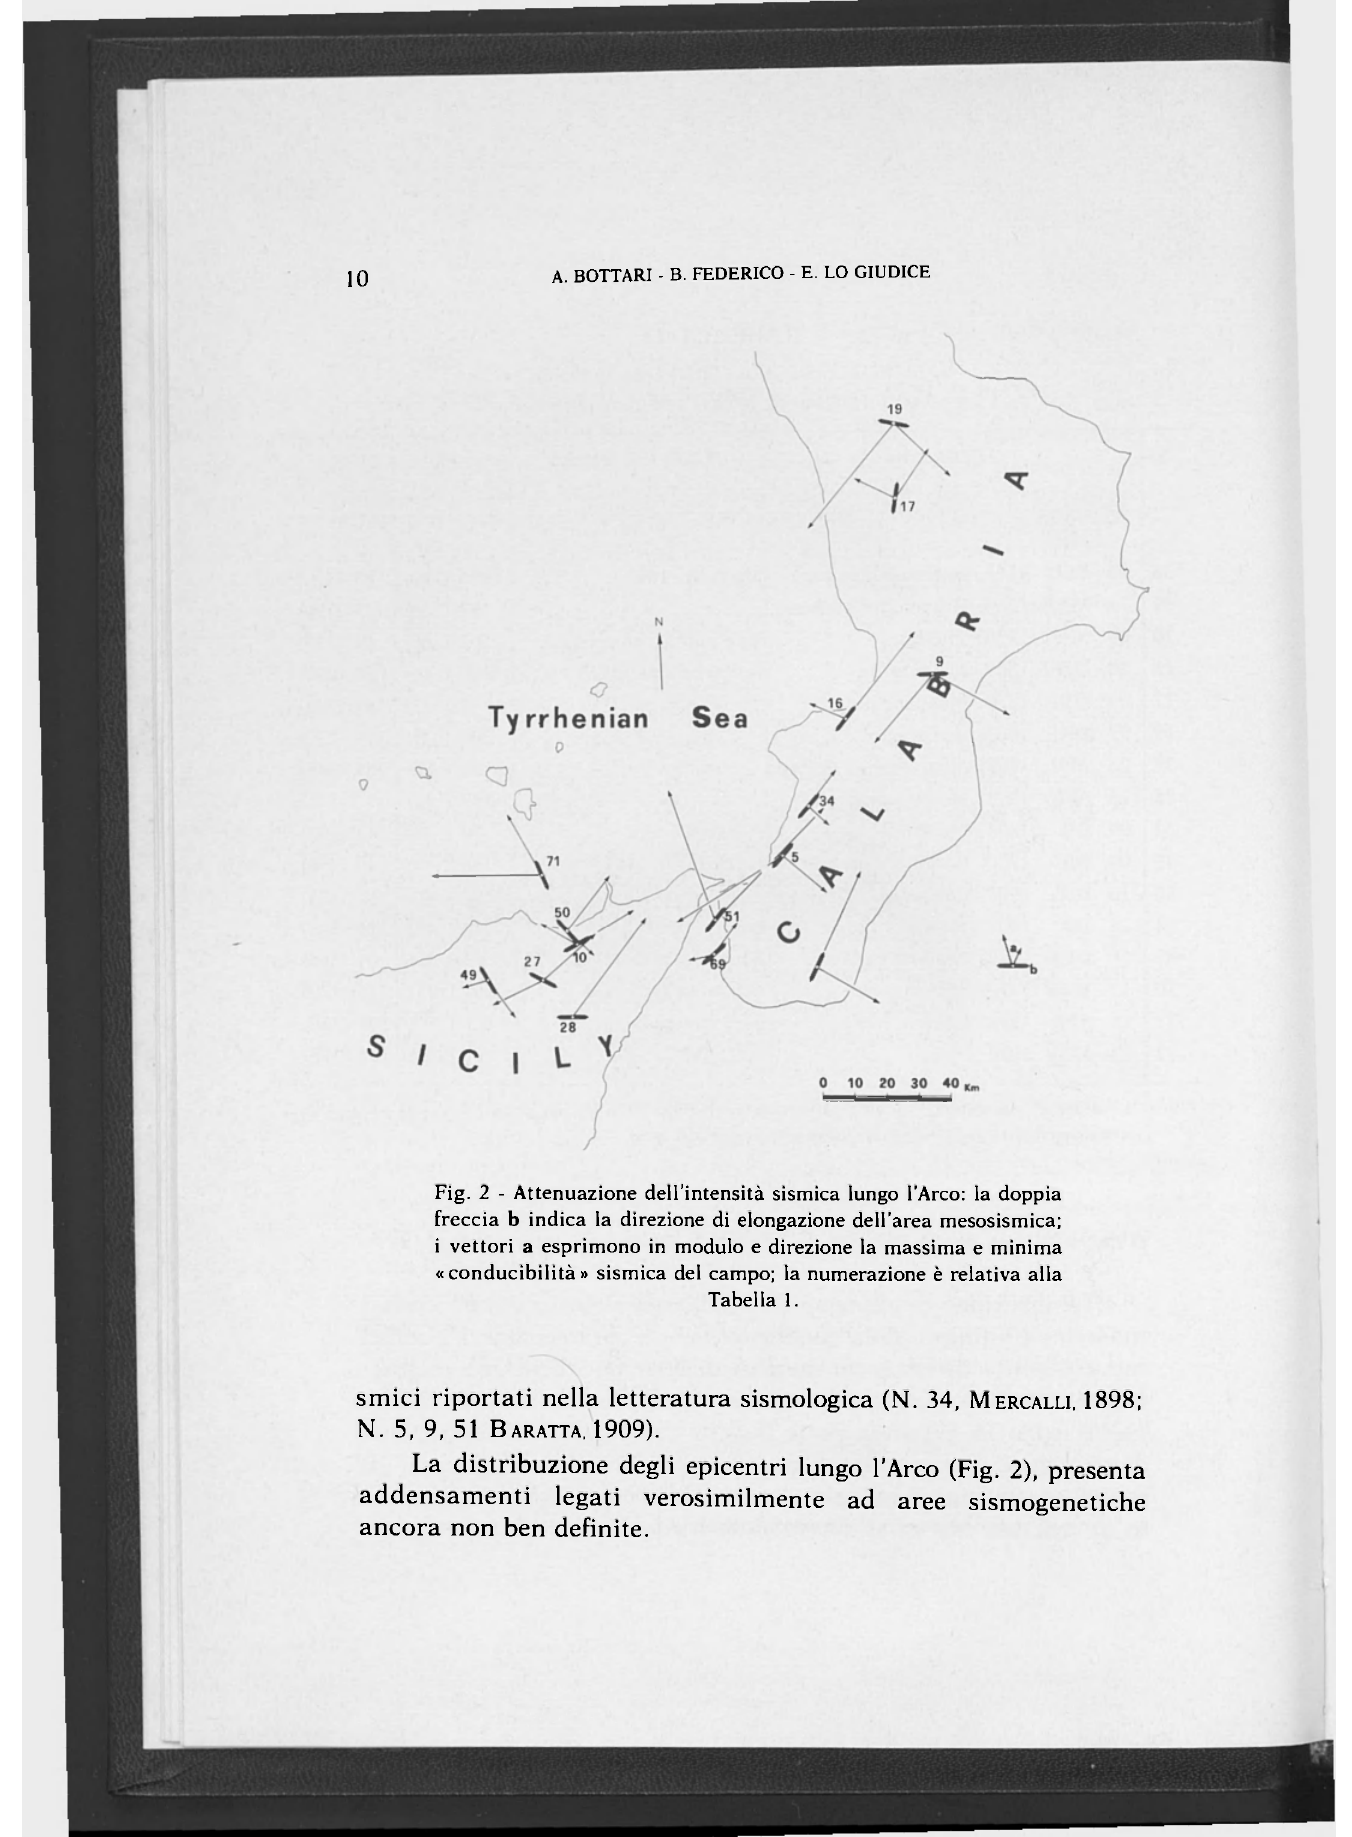
Fig. 2 - Attenuazione dell'intensità sismica lungo l'Arco: la doppia freccia b indica la direzione di elongazione dell'area mesosismica; i vettori a esprimono in modulo e direzione la massima e minima « conducibilità » sismica del campo; la numerazione è relativa alla Tabella